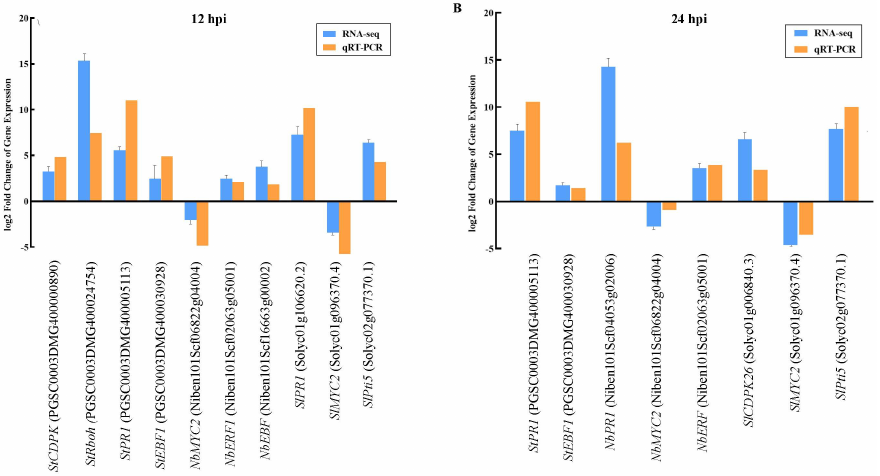
Figure 9. Expression level of marker genes and DEGs obtained by RNA-seq and qRT-PCR vali- dation in potato, N. benthamiana and S. lycopersicum at 12 ( A ) and 24 ( B ) hpi. Error bars represent standard